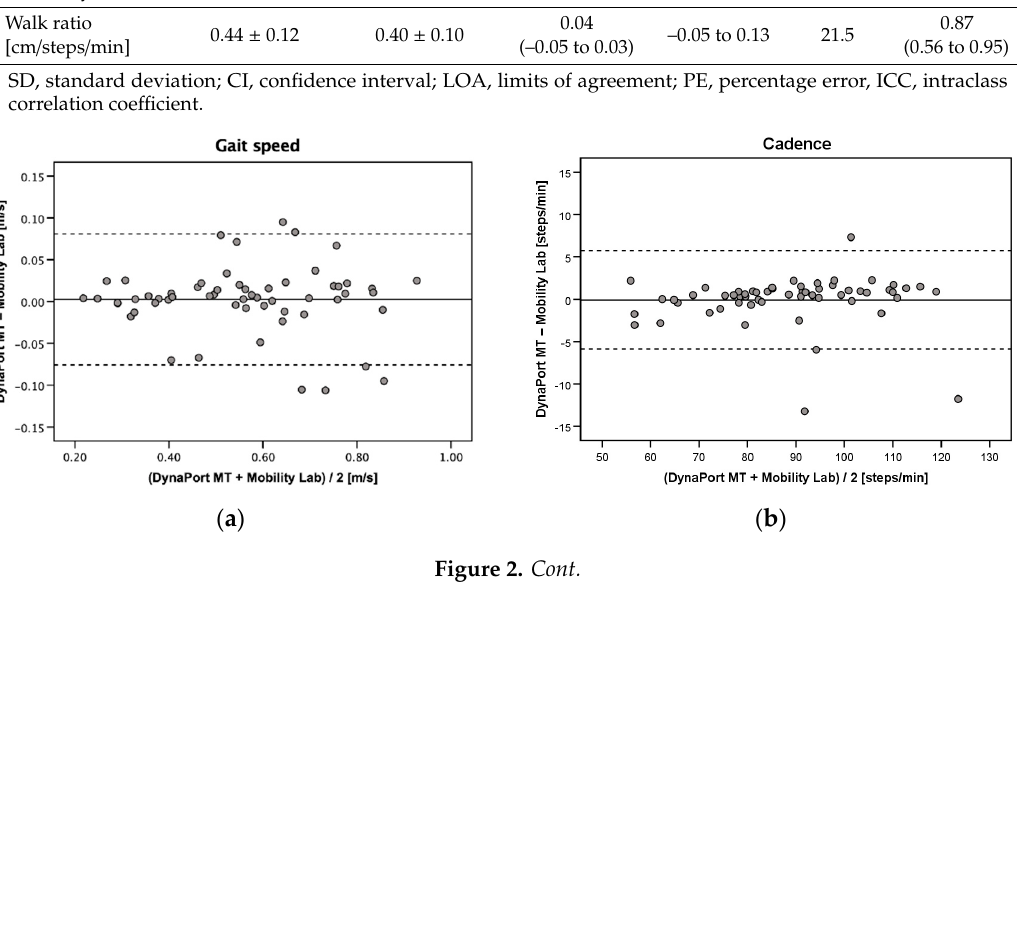
Table 2. Concurrent validity of the DynaPort MT with the Mobility Lab ( n =